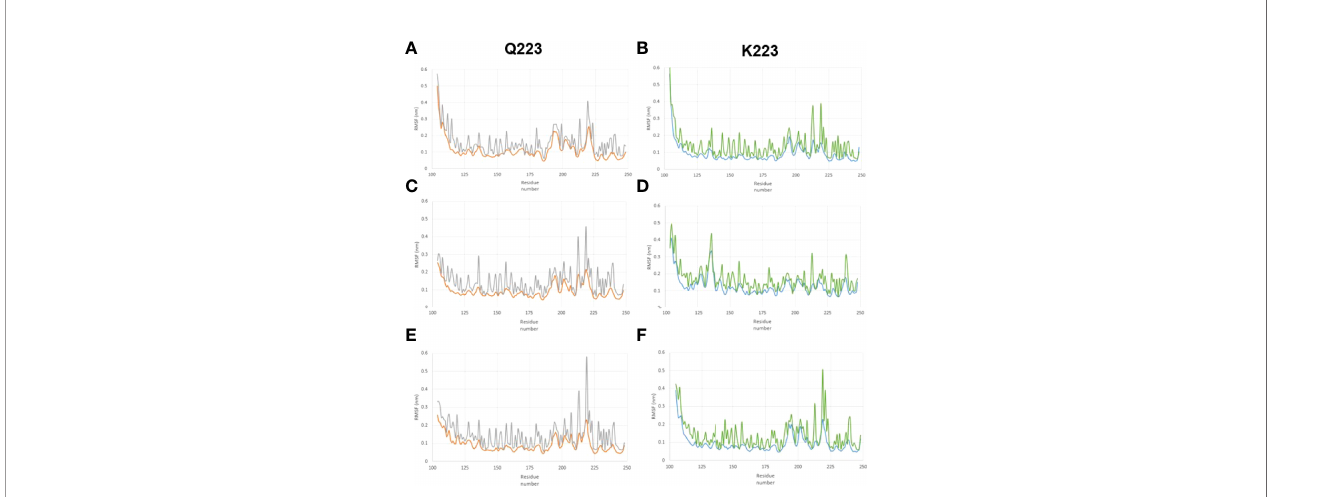
FIGURE 2 | Root-mean-square fl uctuation (RMSF) in the backbone and sidechain of the Q223 and K223 SP-A variants. SP-A homo-trimers consisting of three identical monomers of SP-A1 or SP-A2 that included amino acids 104-224 were studied. The RMSF trimer data of each of the two variants (Q223 and K223) were analyzed for each of the 3 identical monomers present in each trimer to study the behavior of SP-A trimer. (A – C) represent monomers 1, 2, and 3, respectively, for Q223 trimer, and (D – F) represent monomers 1,2,3, respectively, for K223 trimer. The amino acid residue number is on the x-axis and RMSF is on the y-axis. The backbone and sidechain of the Q223 variant, are depicted in orange and gray colors, respectively. Whereas, blue and green colors depict the backbone and sidechain of the K223 SP-A, respectively. The position of peaks did not differ signi fi cantly between Q223 and K223 variants, however, the peak of each residue, in general, is greater for Q223 compared to the K223. The region around amino acid 223 (the site of variation), has more intense peaks, indicating a region with great atomic